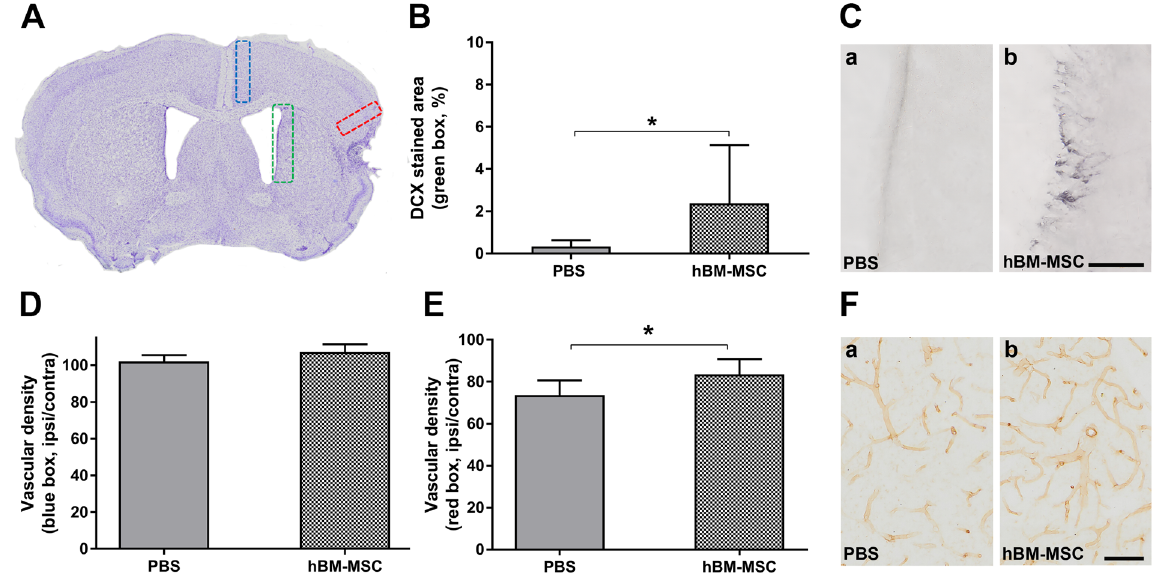
Figure 5. hBM-MSC promote neurogenesis in the subventricular zone and an increase in vessel density. ( A ) Representative micrograph shows the ROI selected for anatomical analyses. Quantification in subventricular zone (green box) indicates a significant increase of DCX in tMCAo hBM-MSC compared to tMCAo PBS mice ( B , C ). ( D ) CD31 analysis shows no difference in medial ROI (blue box), however an increase of vessel density is observed in perilesional cortex (red box) of tMCAo hBM-MSC compared to tMCAo PBS mice ( E , F ). Data are mean + SD, n = 6–10, unpaired t-test. * p < 0.05. Bar = 50 µ m.